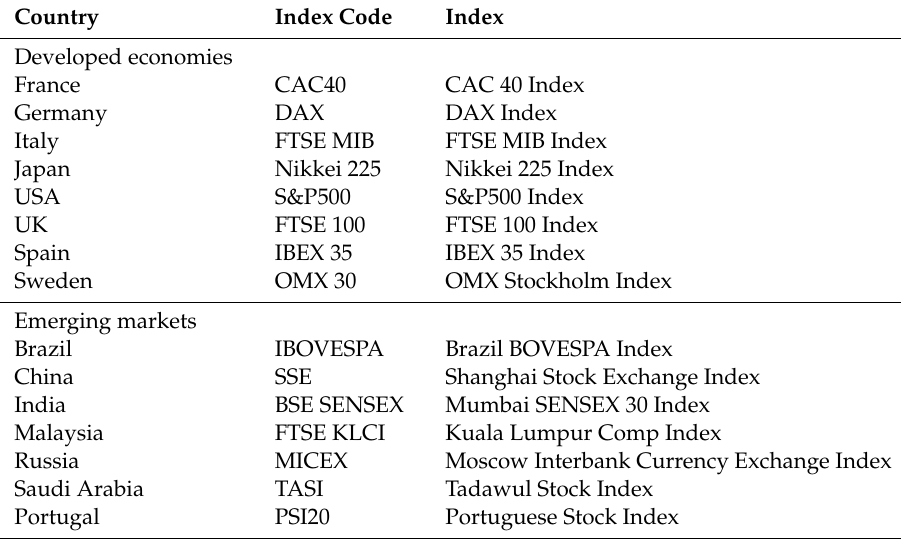
Table 1. Country stock